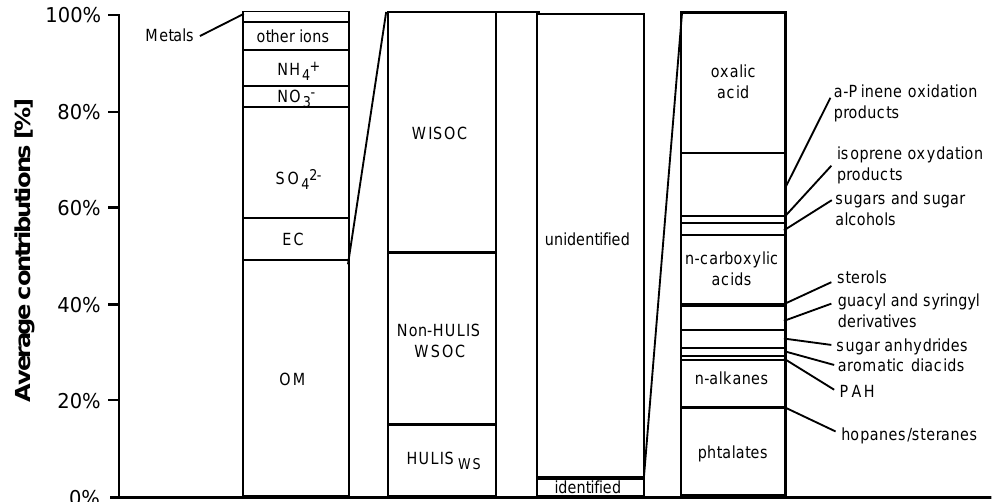
Fig. 6 Fig. 6. PM 2 . 5 average chemical mass balance, over the entire period of study. For HULIS WS (Water Soluble Humic LIke Substances), a pinene and isoprene oxidation products see El Haddad et al.